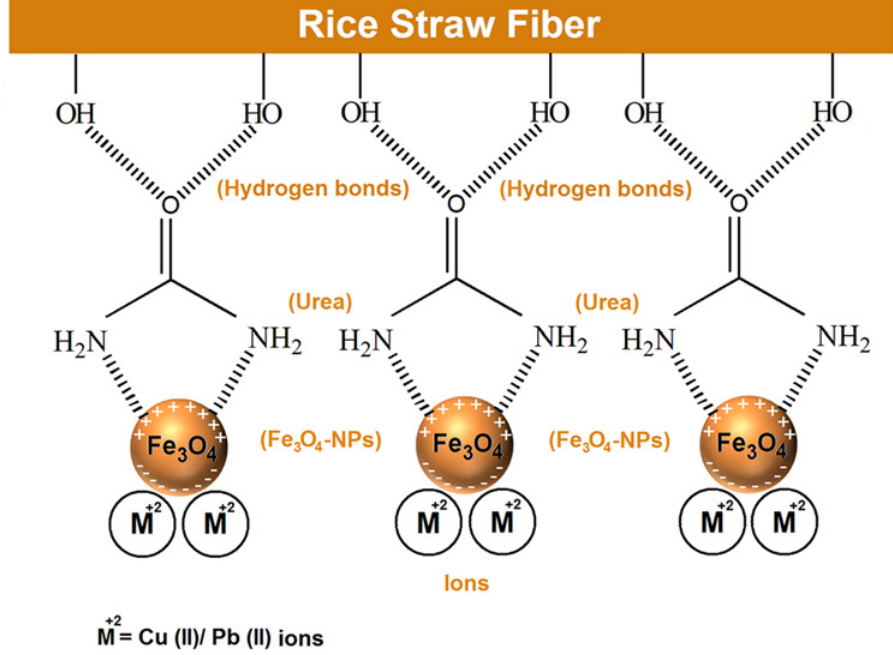
Fig 5. Schematic illustration of adsorption process for Cu(II) and Pb(II) by RS/Fe 3 O 4